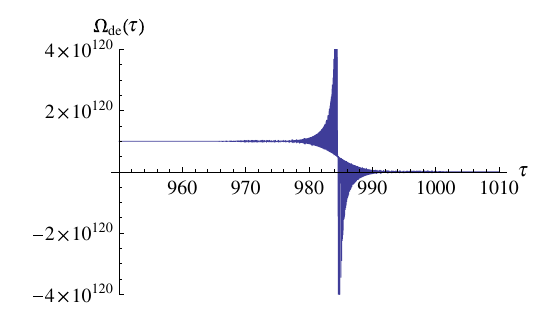
= 10 120 . The 3 H 2 0